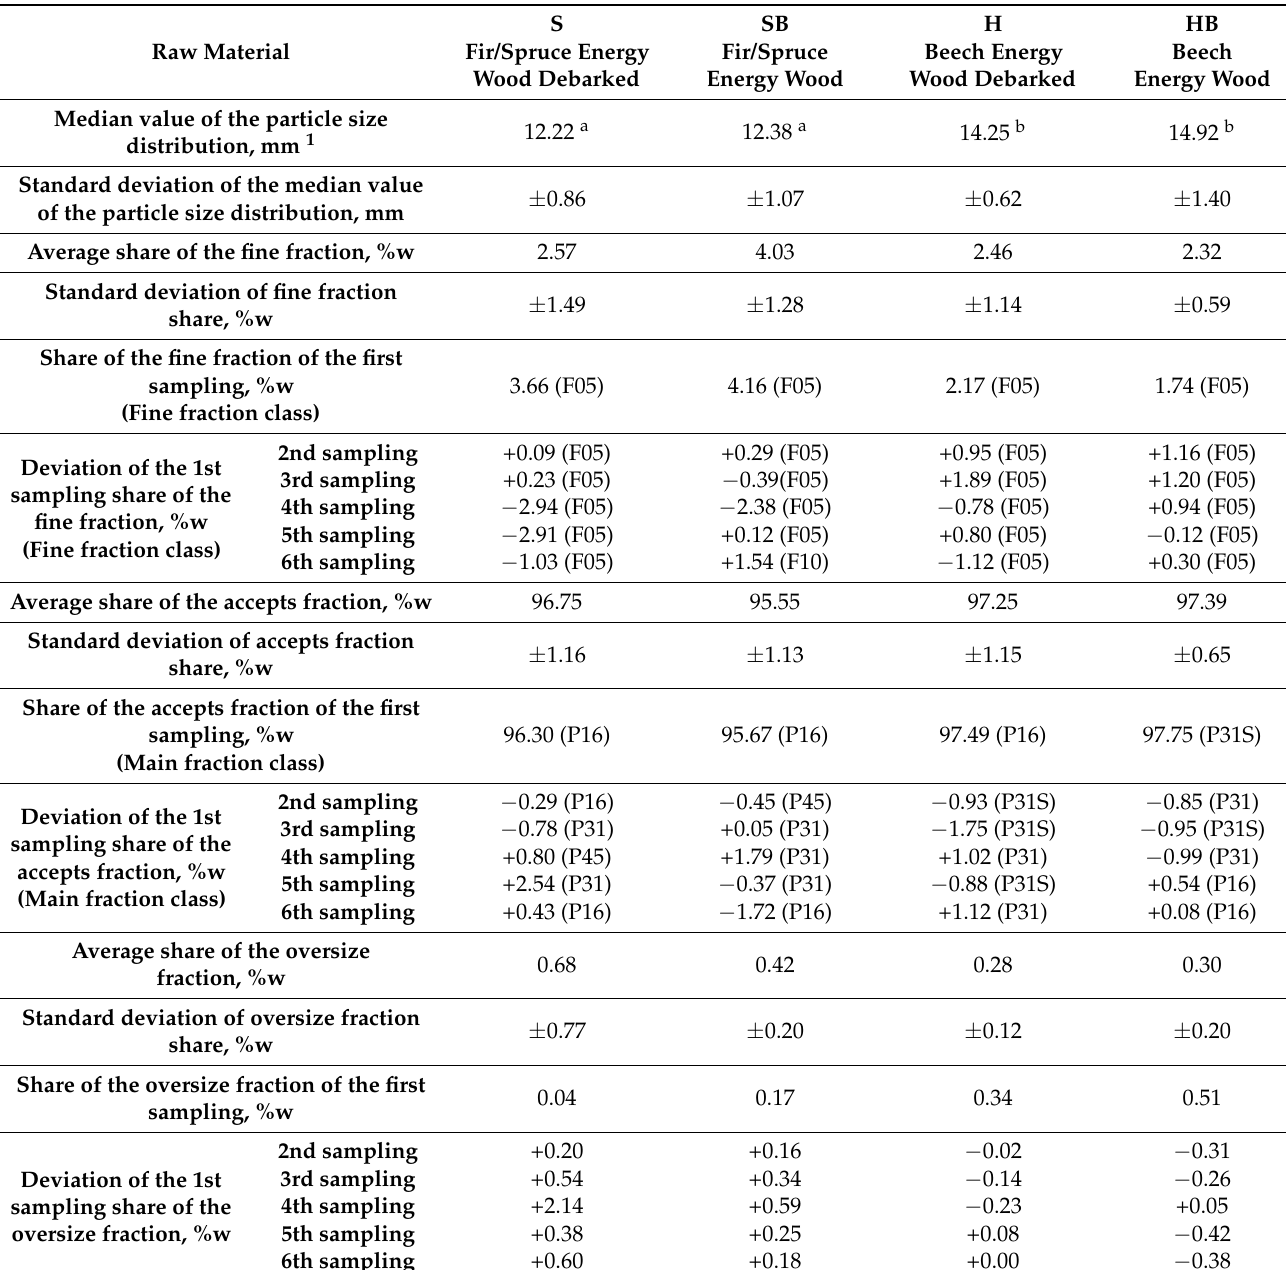
Table 6. Results of the particle size distribution